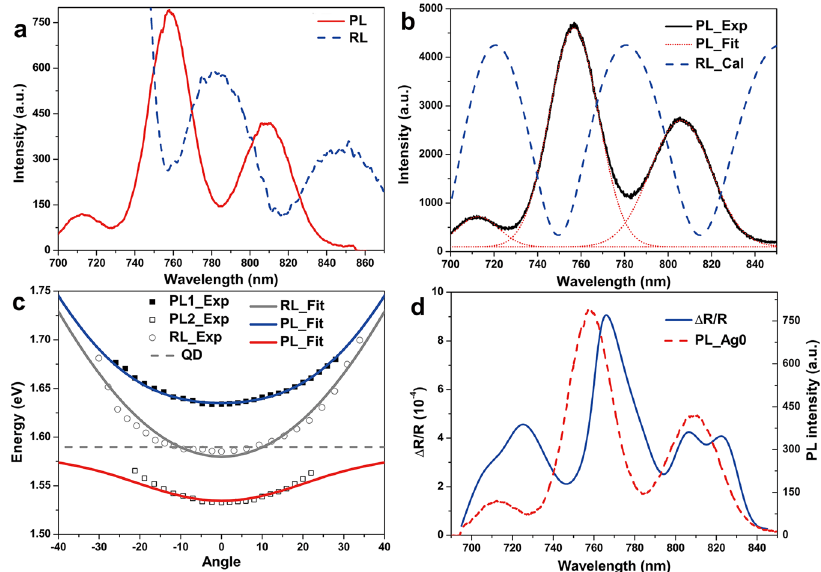
Fig. 4 Strong coupling between colloidal quantum dots (CQDs) and Fabry-Perot (F-P) cavity upon continuous-wave pumping. a Photoluminescence (PL) spectrum (red solid line) from CQDs on SU8/Si compared with re fl ectivity (RL) spectrum (blue dashed line) from SU8/Si at normal incidence. b PL spectrum (black solid line) from CQDs on SU8/Si and calculated re fl ectivity spectrum (blue dashed line) from 3- µ m-thick SU8/Si and at normal incidence. The short-dotted lines are fi ttings to multiple Gaussians. c Central peak energies of the PL spectra and the re fl ectivity spectra as a function of incident angle. Solid and open squares represent the measured PL peak energies (denoted by symbols of PL1_Exp and PL2_Exp), and open circles represent the measured re fl ectivity peak energies (denoted by RL_Exp). The gray curve is a fi tting to Eq. (1) for the F-P mode (denoted by RL_Fit), and the blue and red solid curves are fi ttings to Eq. (2) for strong coupling (denoted by PL_Fit). The horizontal dashed line shows the exciton transition energy. d Comparison of PL spectrum (red dashed line, denoted by PL_Ag0) from CQDs on SU8/Si at normal incidence with the maximum amplitude of the differential re fl ectivity ( Δ R/R) as function of wavelength. Δ R/R was measured under the same pump power (5.5 mW) at different wavelength with femtosecond pump